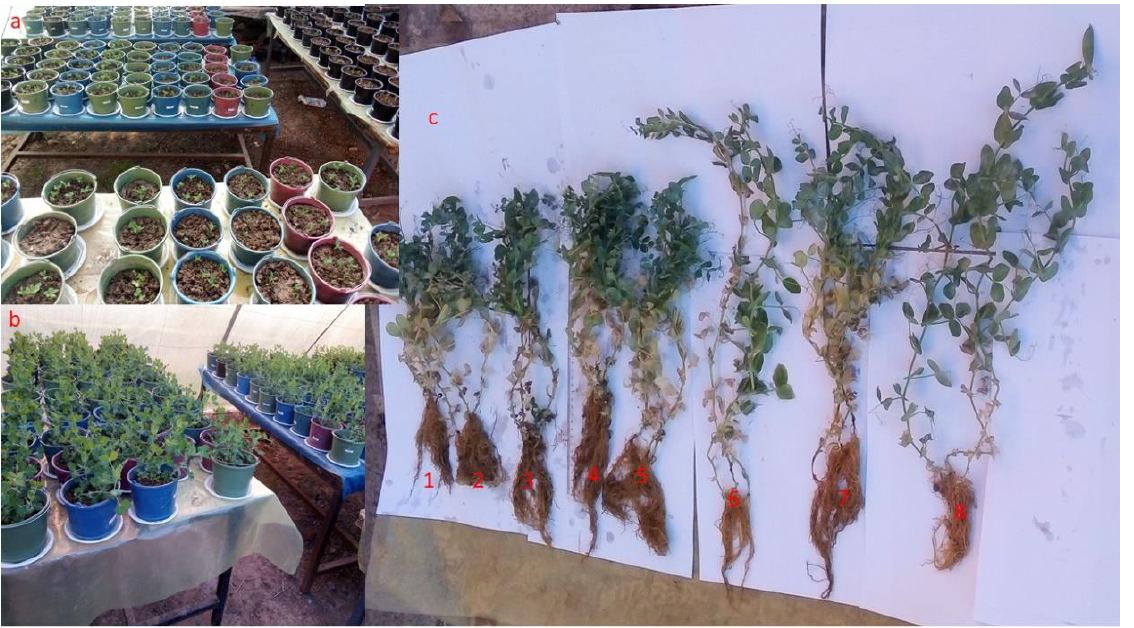
Figure 4. Morphometric appearance of pea plants ( a ) at the time of seedling transplantation into pots, ( b ) at the vegetative stage, and ( c ) after three months of cultivation at the time of harvest (without fruits); in ( c ), plants watered with 100 µg MC/L and the bacterial strains were added in different combinations, where 1, 2, 3, 4, 5, 6, 7, and 8 correspond to NI (sterile control) and inoculation with A, B, C, A × B, A × C, B × C, and A × B × C respectively.